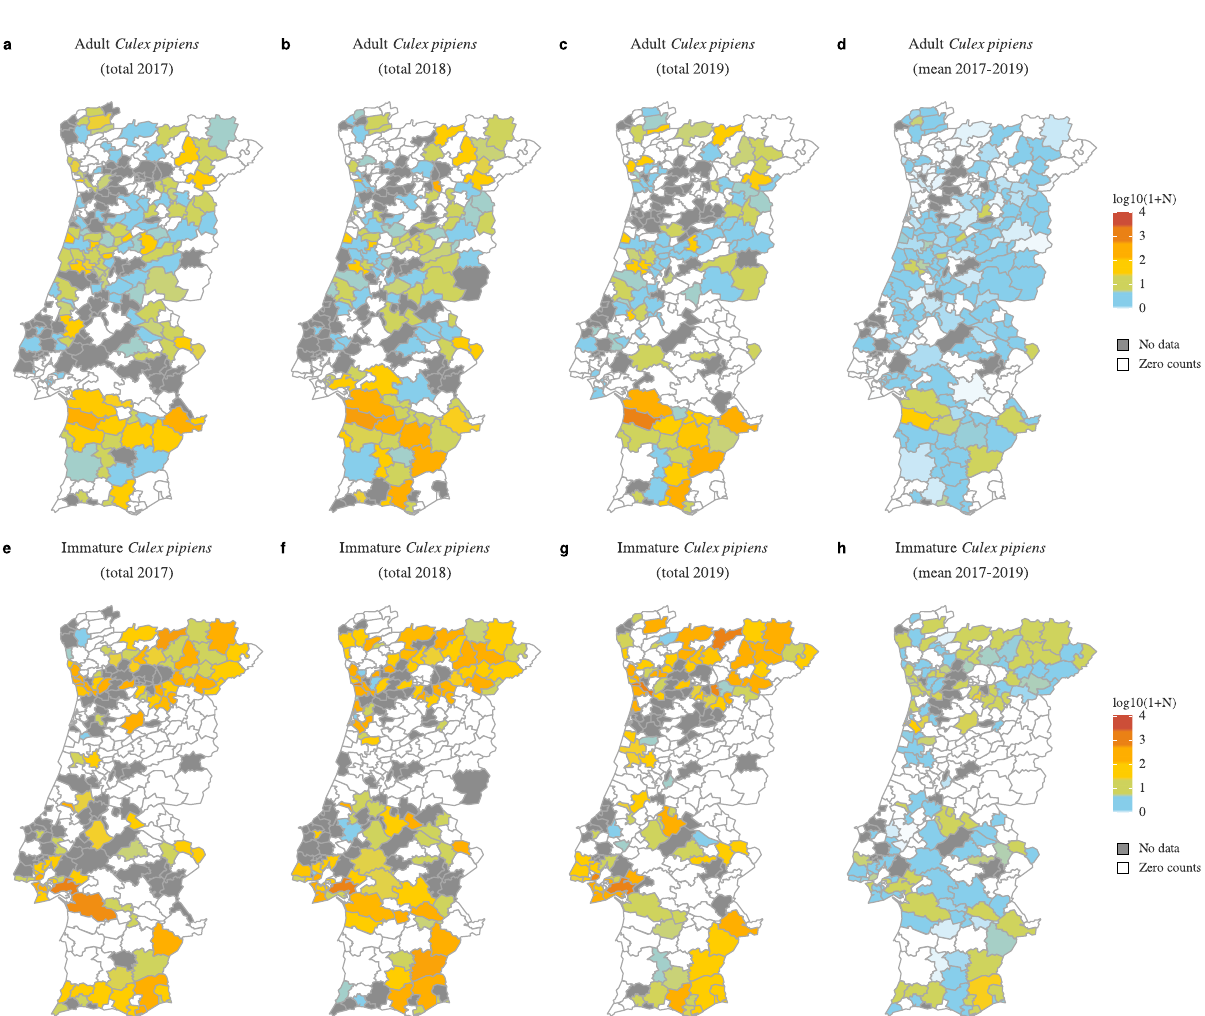
COMMUNICATIONS BIOLOGY| (2022) 5:6